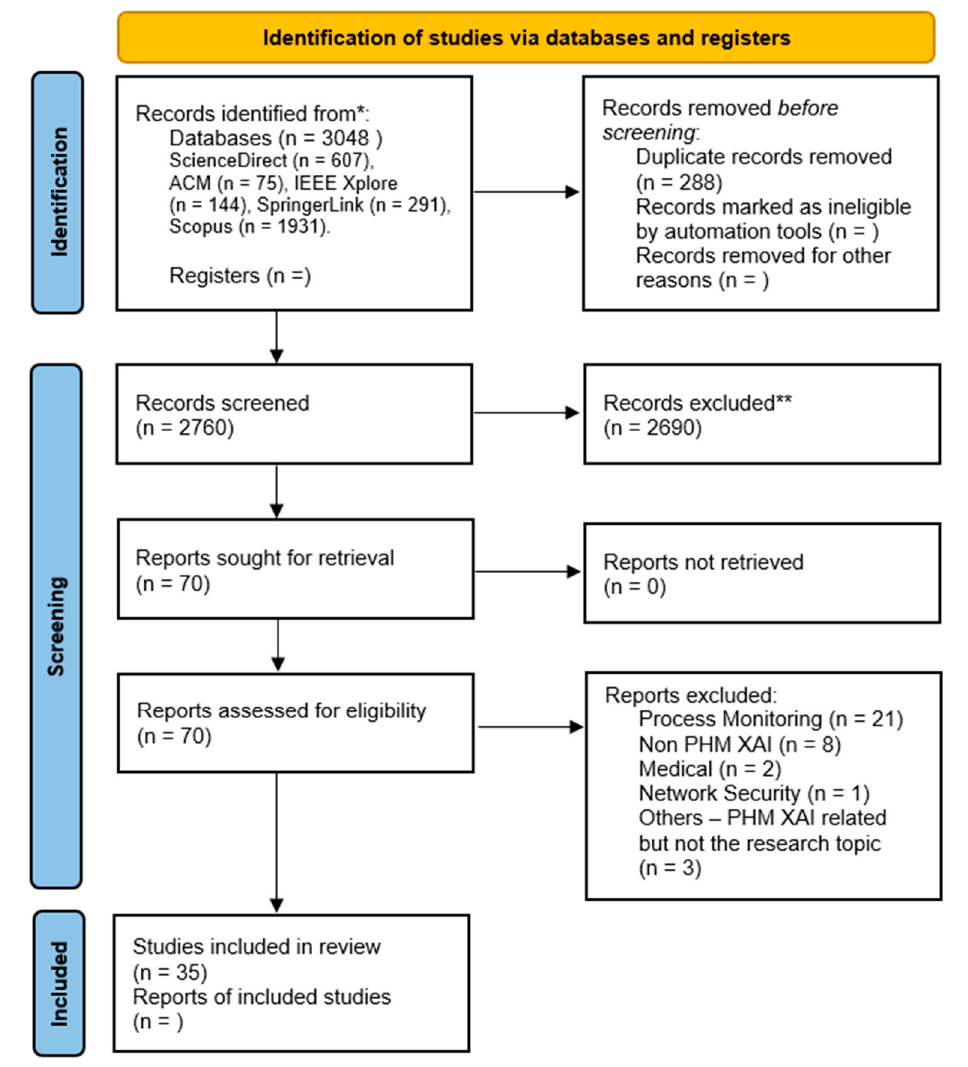
Figure 2. PRISMA flow diagram of the search strategy for our review on PHM-XAI.3.3 (“*” indicates that “n = ” in the database field corresponds to the total number of records from all the databases specified below; and “**” states that the Zotero software was used for duplication analysis).